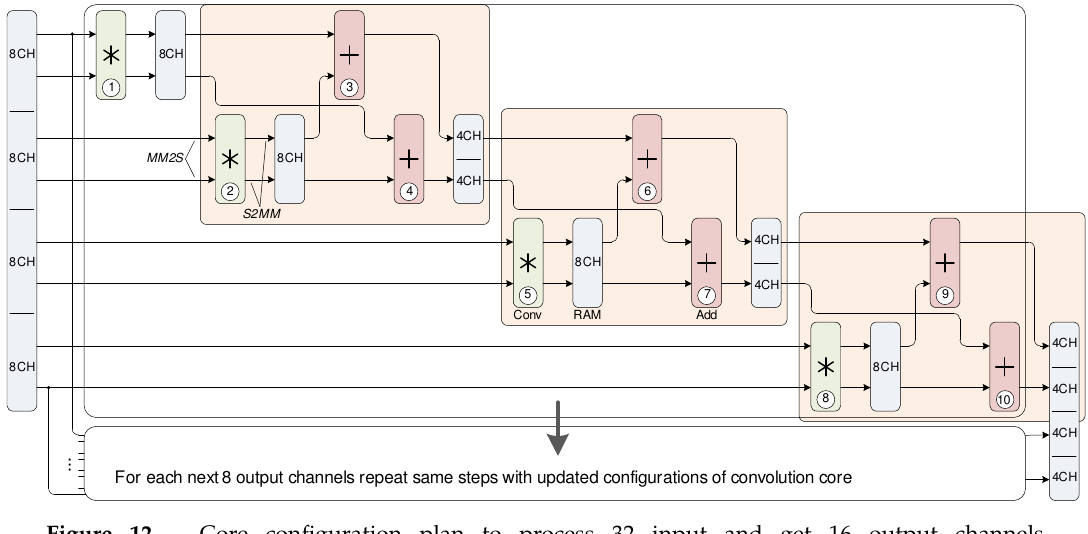
Figure 12. Core configuration plan to process 32 input and get 16 output channels. Green block—convolutional core; red block—addition core; gray block—on-board RAM; arrows—AXI DMA